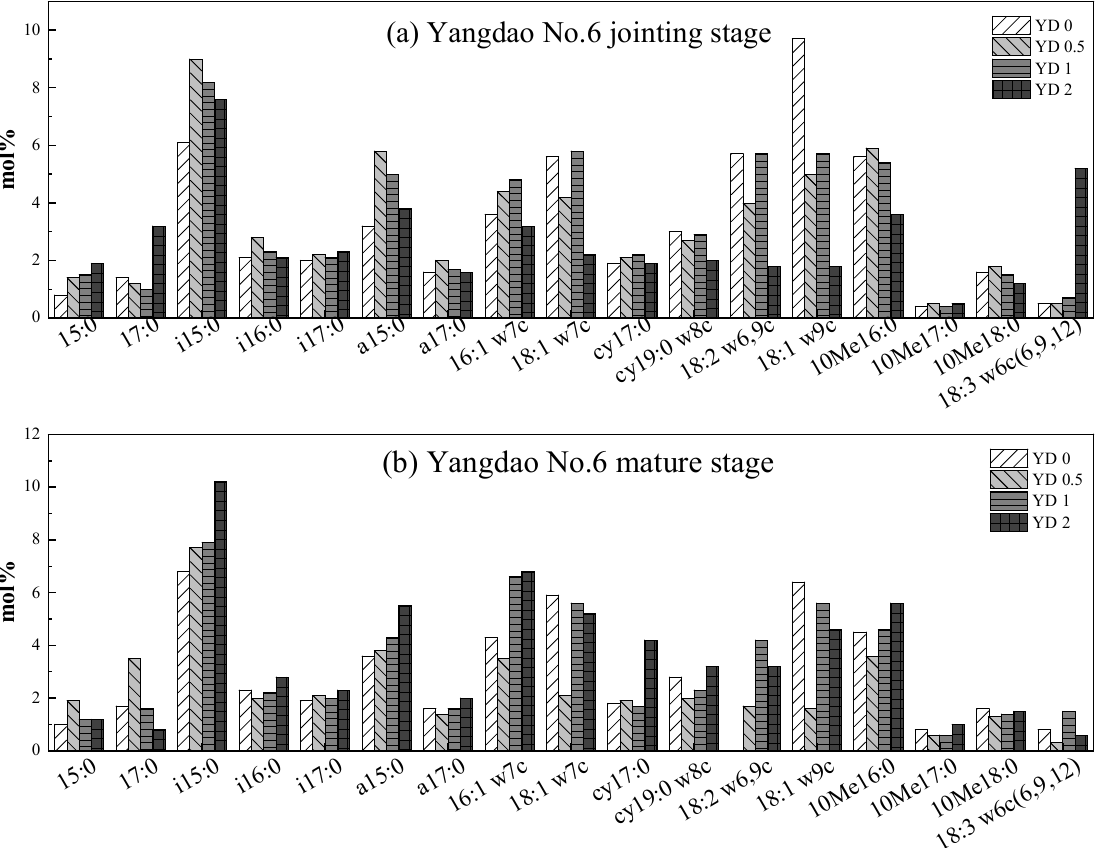
Figure 3. Distribution of PLFA with different concentrations of exogenous phosphorus added to YD: YD represents the YD; the numbers after YD represent the molar ratio of exogenous phosphorus to lead.